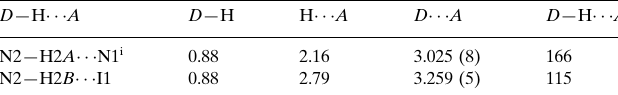
Hydrogen-bond geometry (A˚ , (cid:2)